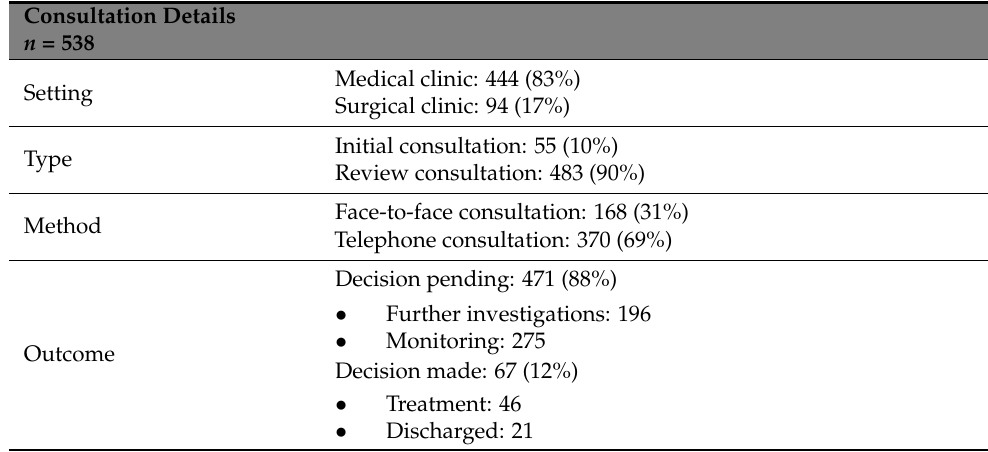
Table 1. Details of the consultation setting, type, method, and outcome.